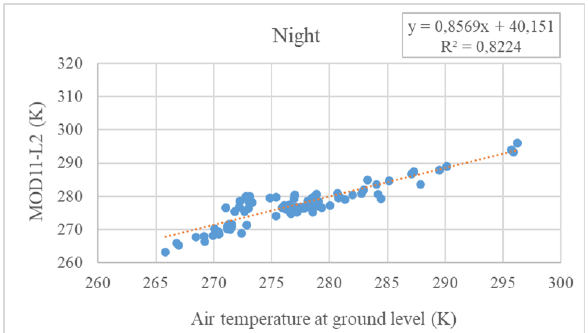
Figure 6. Correlation between pixel-based MOD11-L2 and air temperatures at ground level for all MODIS satellite products available for the same dates for which AST-08 products were available.